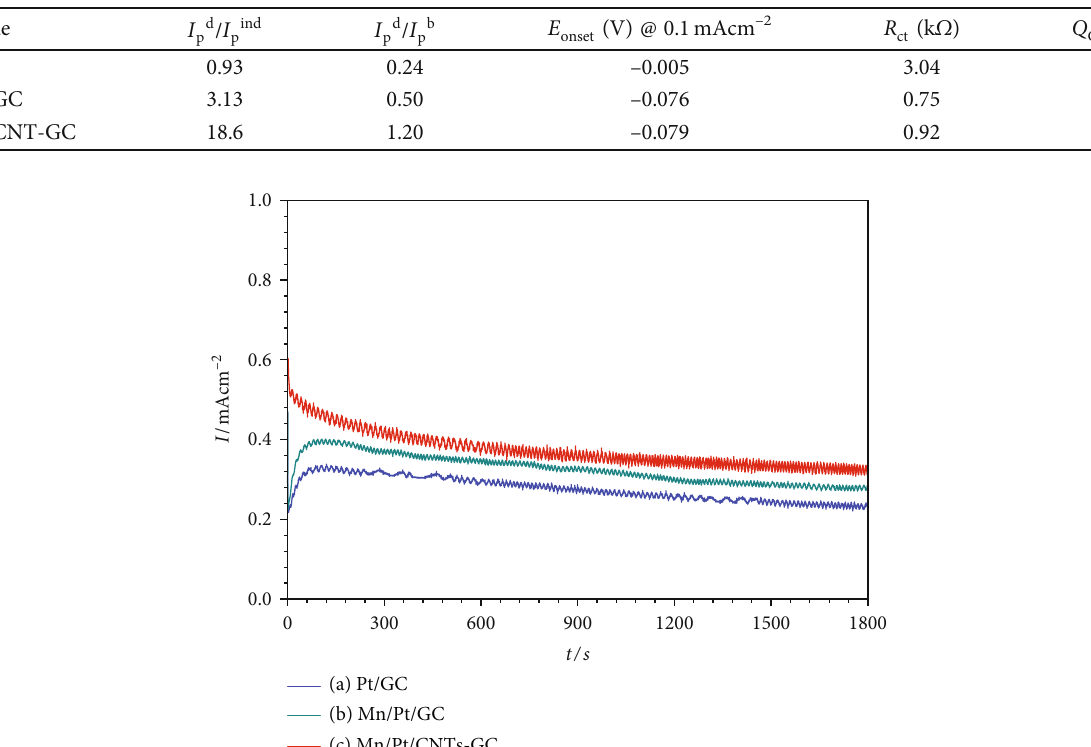
Figure 4: Current transients obtained at the (a) Pt/GC, (b) Mn/Pt/GC, and (c) Mn/Pt/CNT-GC electrodes in 0.3M FA ( pH = 3 : 5 ) at 0.25V.